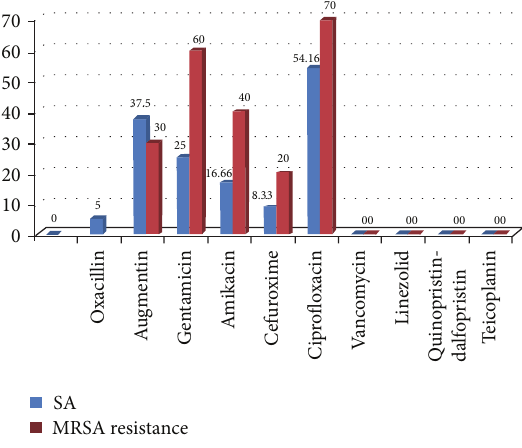
Figure 1: Comparative resistance of SA and